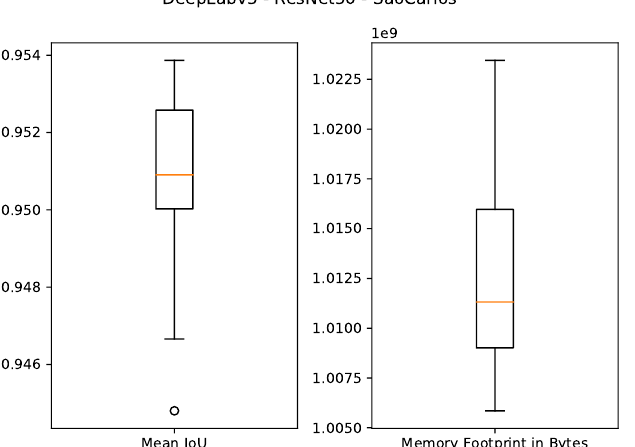
Figure 7. Boxplot results for the São Carlos Rivers dataset using the ResNet50 backbone and 1 GB of desired memory